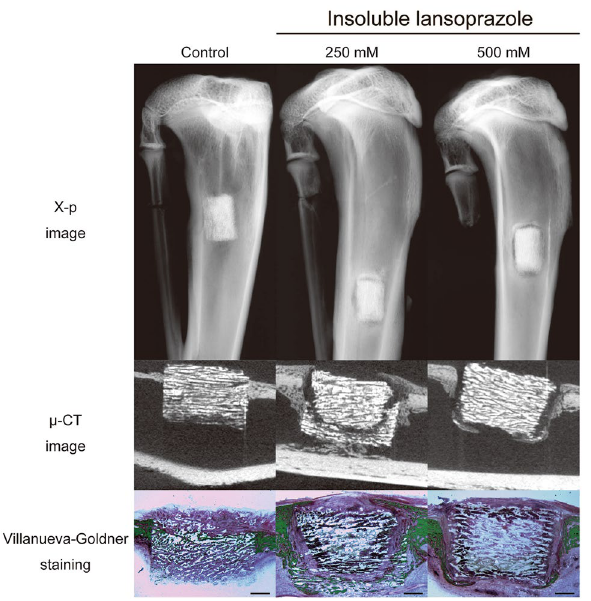
Figure 1. Radiographic, µ-CT, and histological images of insoluble lansoprazole-impregnated artificial bones embedded for four weeks in a rabbit cortical bone defect model. Note that radiolucent areas around lansoprazole-impregnated materials correspond to dense fibrogranulomatous tissues on histology (Villanueva- Goldner staining). In contrast to the control one, the insides of the experimental materials surrounded with the fibrogranulomatous tissues are devoid of newly-formed bones (green). Scale bars, 1